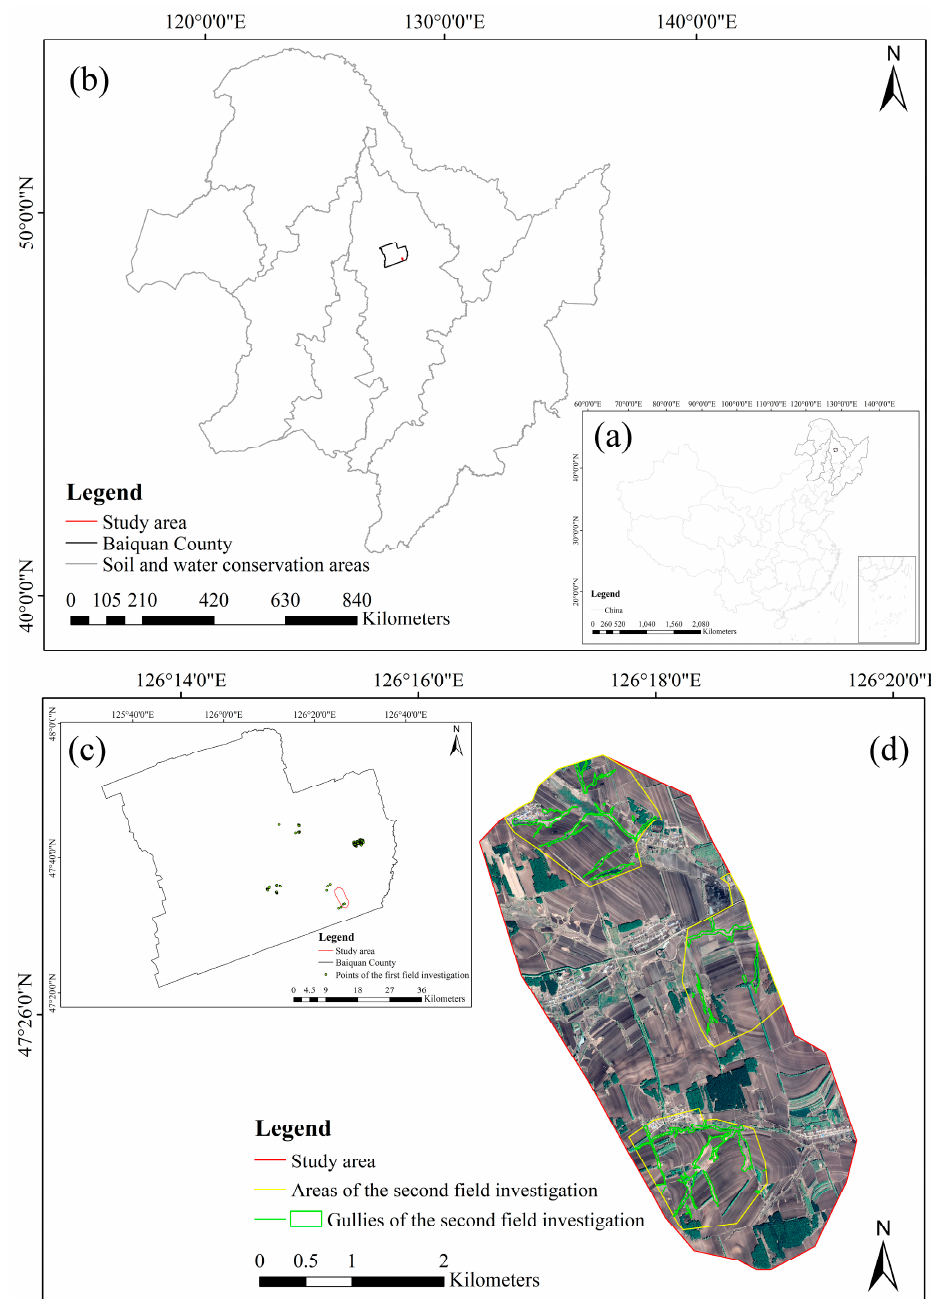
Figure 1. Location of the study area. ( a ) China. ( b ) Soil and water conservation areas of the black soil region, Northeast China. ( c ) Baiquan County and points of the first investigation. ( d ) Study area and areas and gullies of the second investigation shown in GE image at 0.5 m spatial